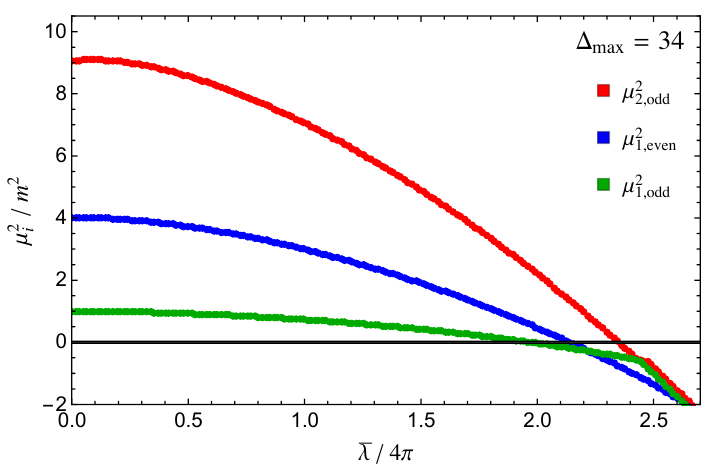
Figure 2 . The two lowest mass eigenvalues in the odd sector and the lowest eigenvalue in the even sector as a function of (cid:22) (cid:21) for (cid:1) max = 34 (12,310 basis